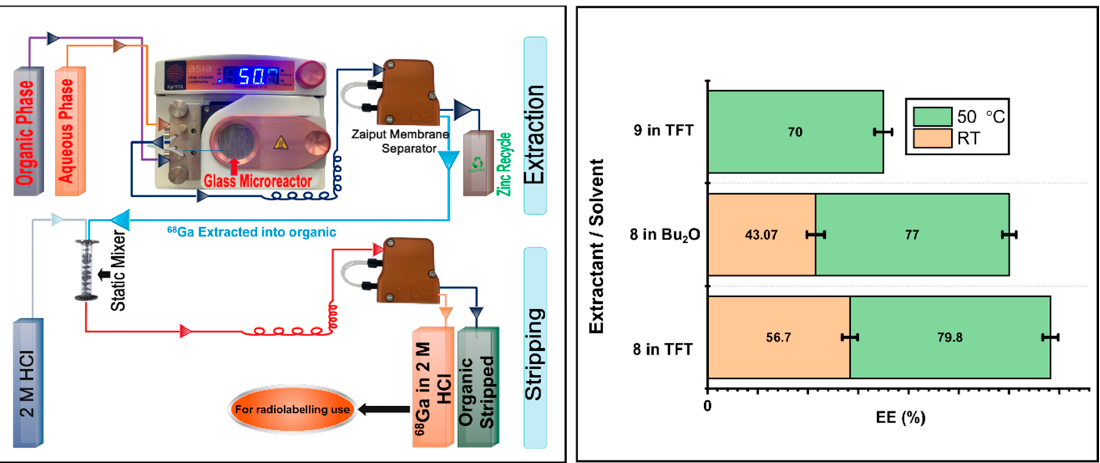
Figure 5. ( Left ) A schematic depicting two-stage liquid–liquid extraction in flow. ( Right ) 68 Ga EE (%) obtained from a 1 M Zn(NO 3 ) 2 solution in 0.01 M HNO 3 using extractants 8 and 9 in TFT and Bu 2 O at RT and 50 °C.